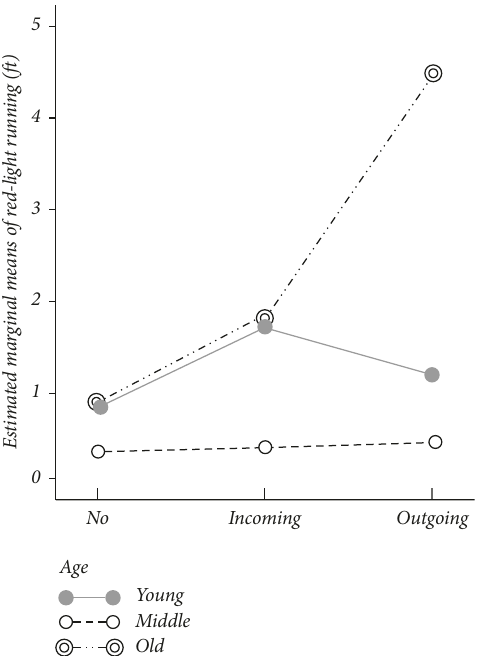
Figure 4: Two-way interaction between cell phone interface and